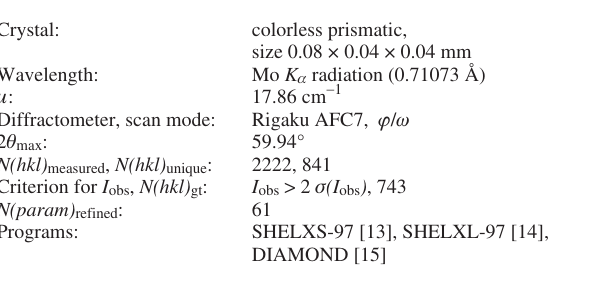
Table 1. Data collection and